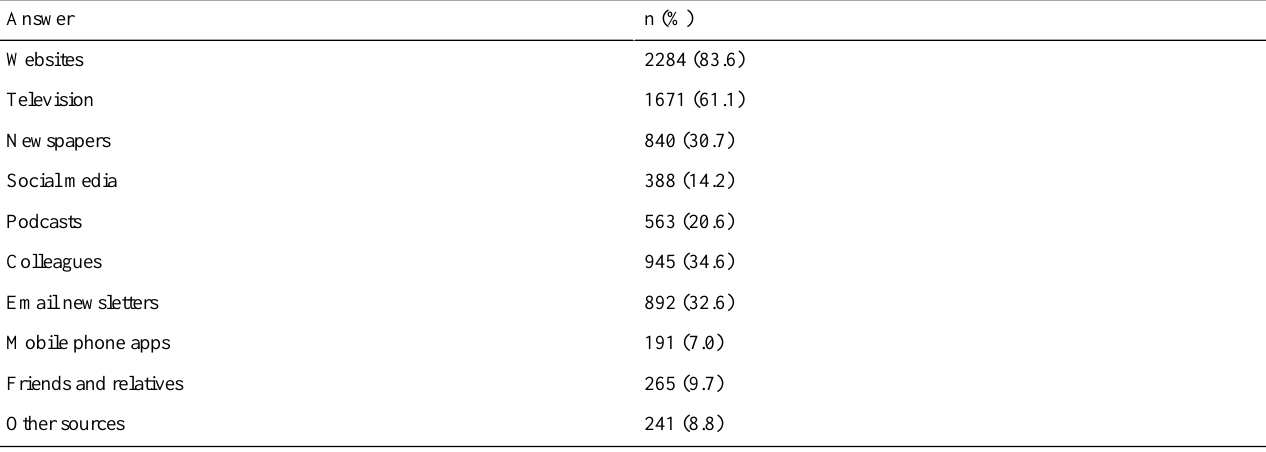
Table 8. Information sources about the pandemic used by participants; responses to the question "What are the top 3 sources you mainly use to inform yourself about the current coronavirus disease pandemic?"